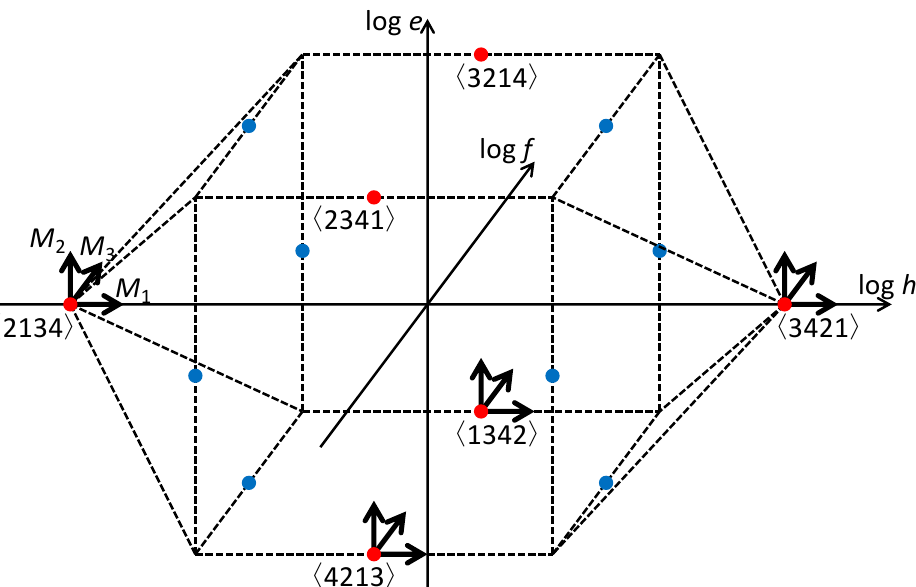
Figure 7 . The three-dimensional subspace of brane con(cid:12)gurations C B in the (cid:12)ve-dimensional space of point con(cid:12)gurations C P . Red dots and blue dots denote the (2 ; 2) model and the (1 ; 1 ; 1 ; 1) model without rank deformations respectively. Although the origins of the (2 ; 2) model without rank deformations are shifted in changing the frames, the directions of rank deformations ( M 1 ; M 2 ; M 3 ) are